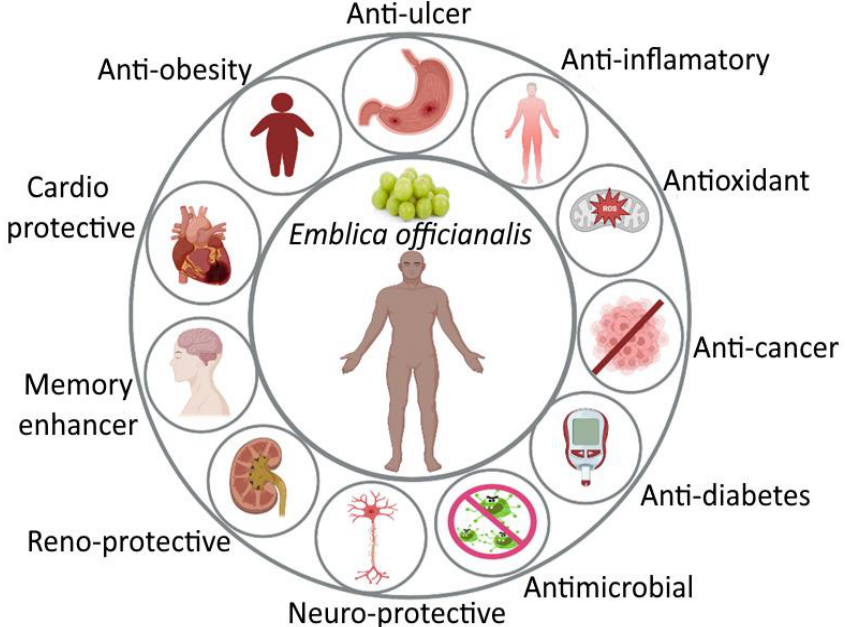
Figure 2. Different pharmaceutical activities of E. officinalis .